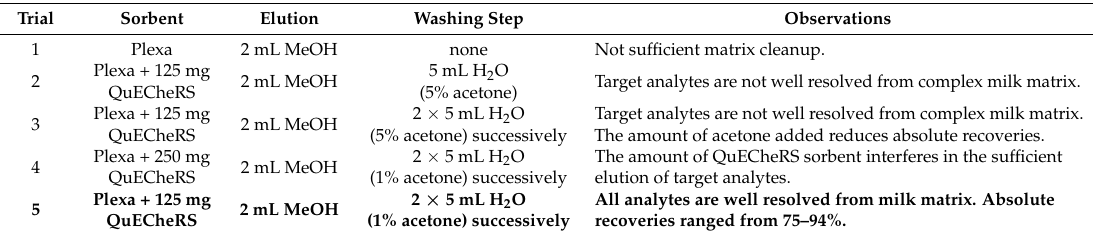
Table 2. Optimization of Matrix Solid-Phase Dispersion (MSPD) procedure.